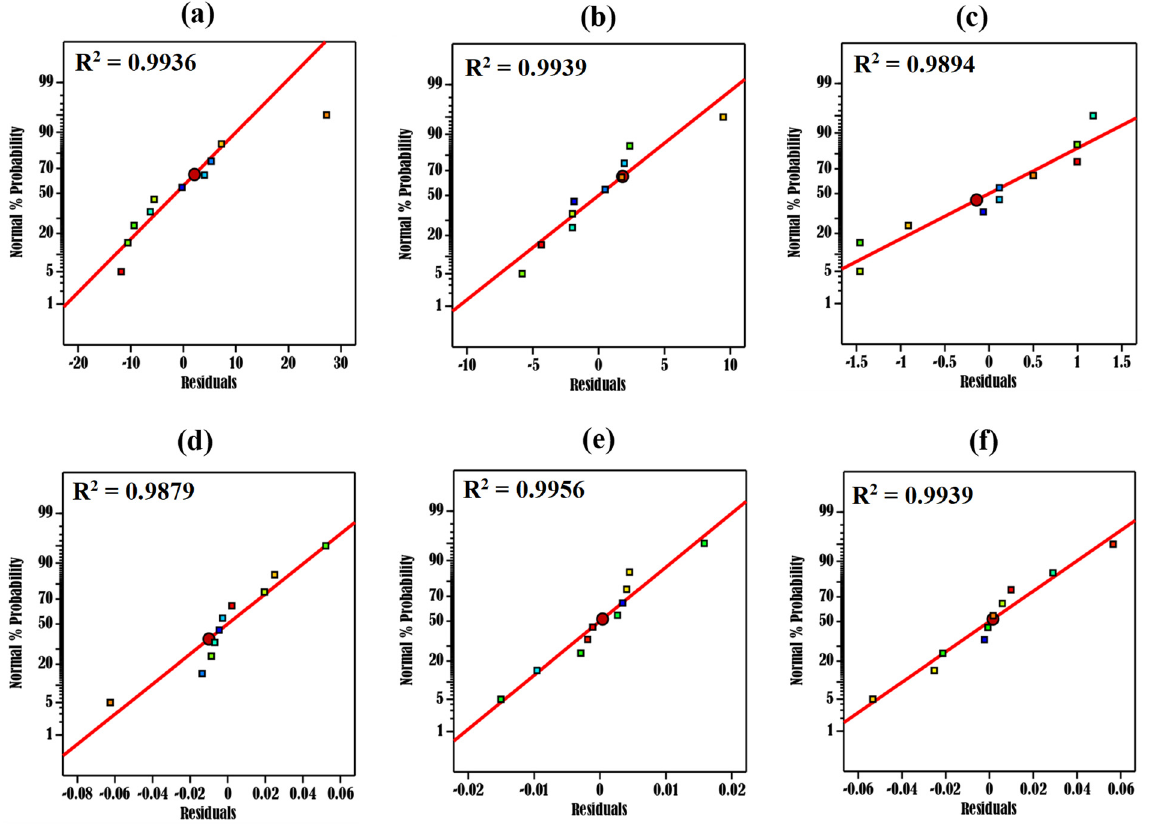
Figure 4. Probability plot for the responses.